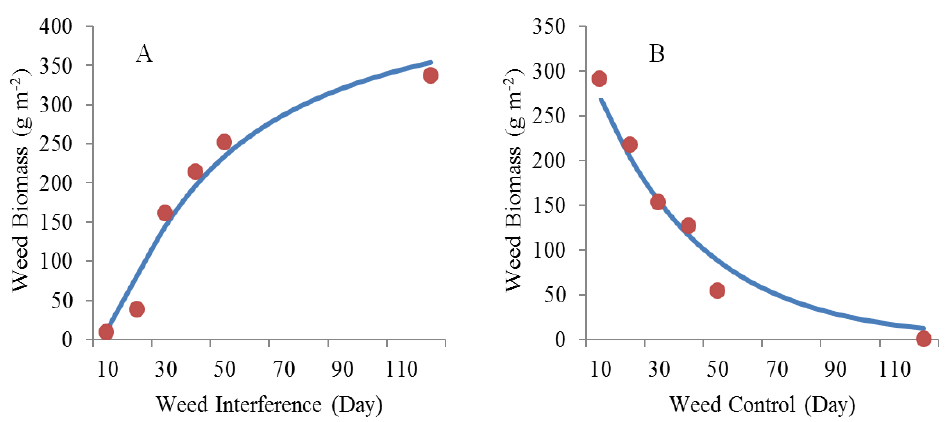
Fig. 1. Effects of increase in duration of weed interference (A) and weed free periods (B) on weed biomass. Dots indicate observed data. Parameter values for fitted curves are given in Tab. 2